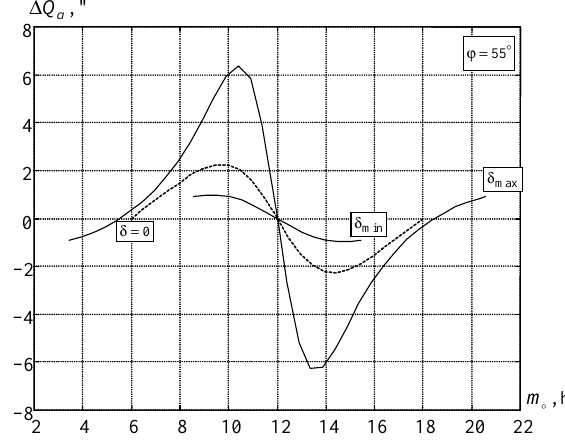
Fig 6. Variation of acceleration